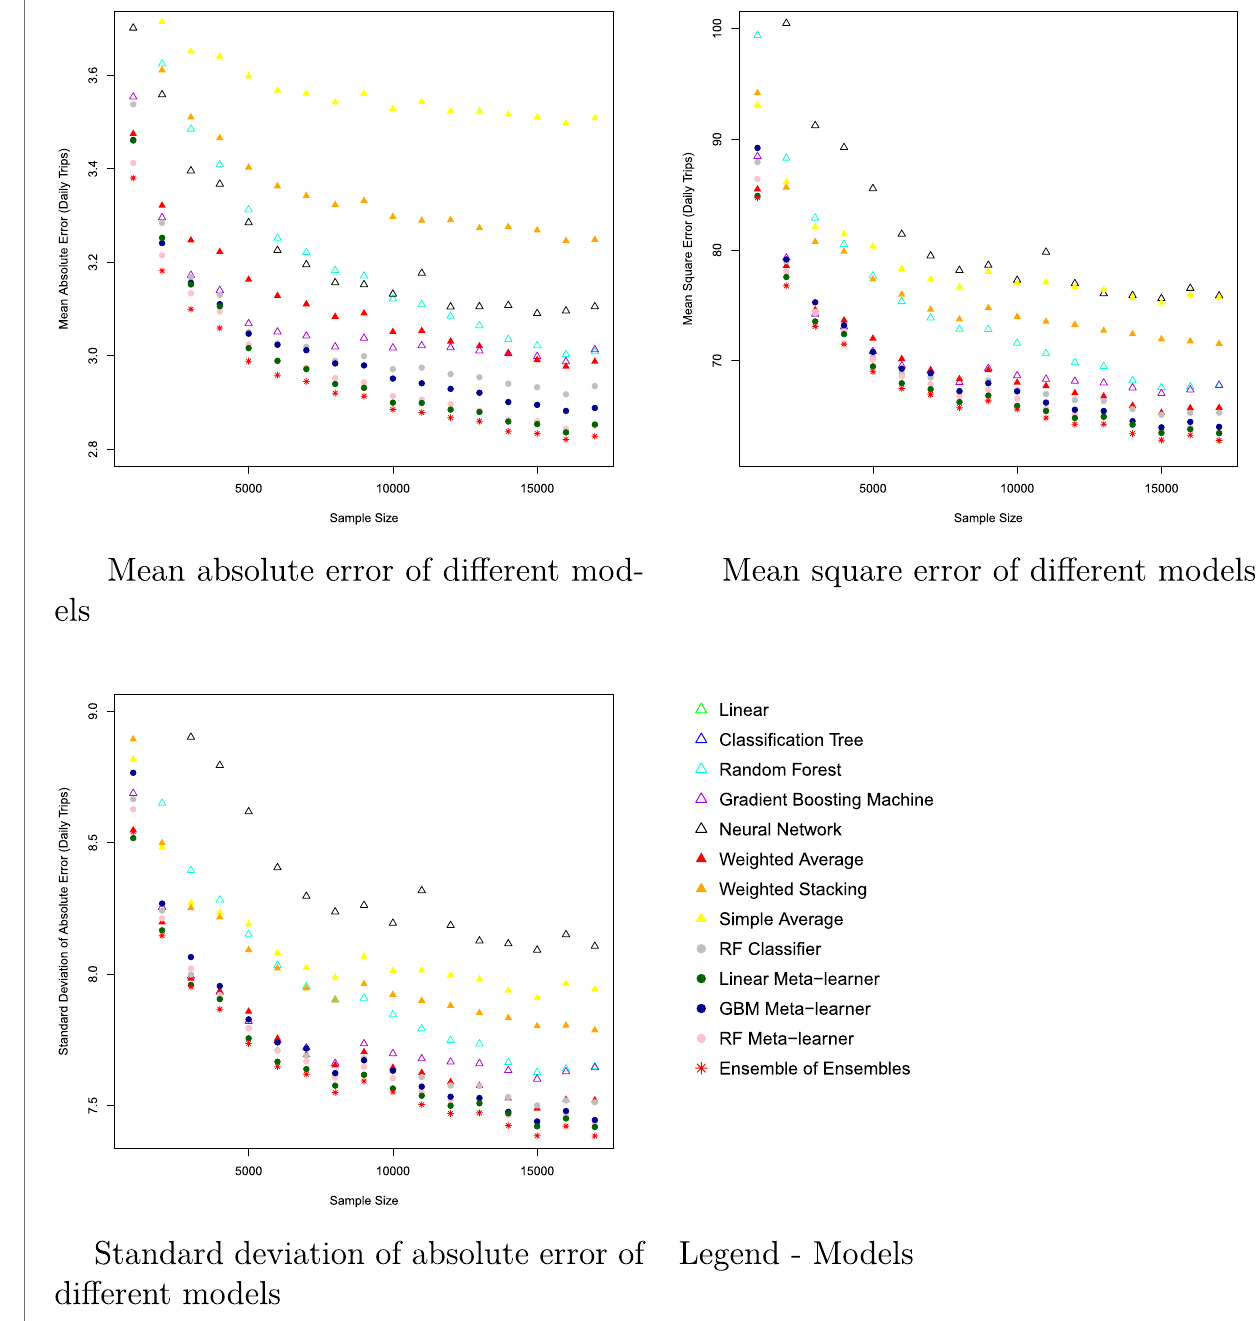
FIGURE 8 | Model peformance in predicting New York City FHV fl ow; Every dot is the average of 90 experiments, each with 100 testing samples.